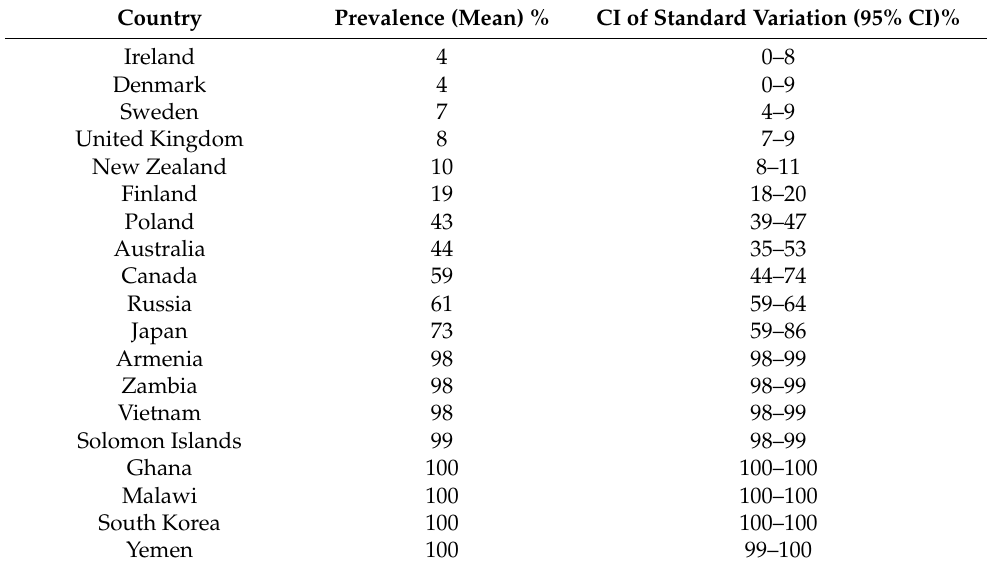
Table 1. Lactose malabsorption or lactase non-persistence prevalence data in adults and children aged 10 years or older, based on [12].